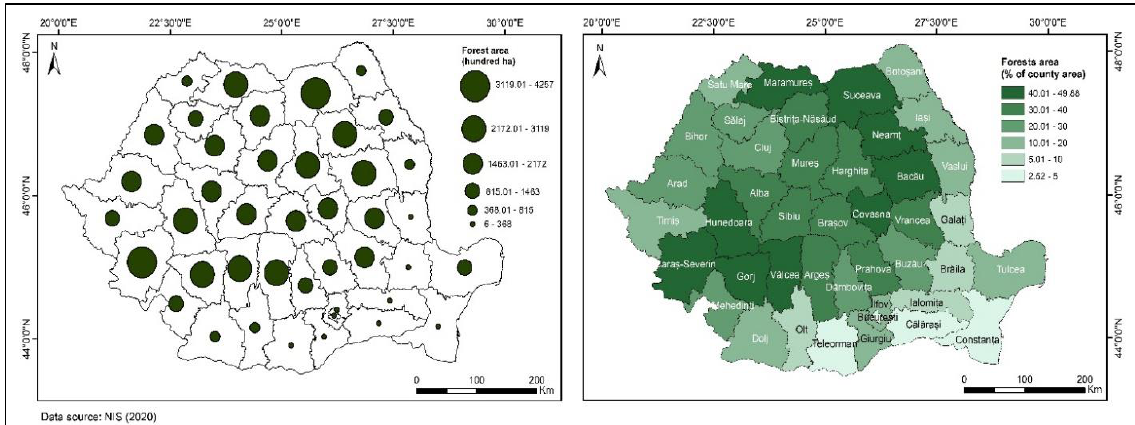
Figure 2. Forest area distribution at the county level in Romania (data source: [29]).